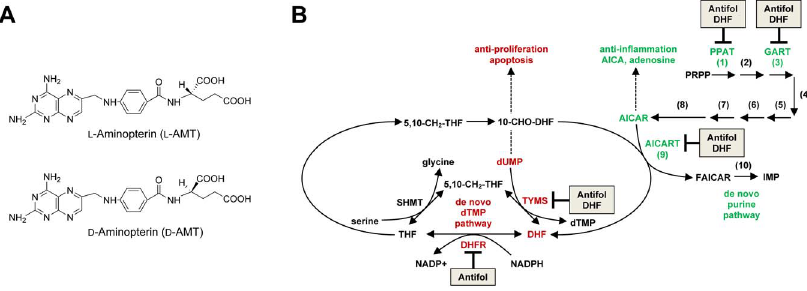
Figure 1. LD-Aminopterin composition and mechanistic model in anti-inflammation. (A) Chemical structure of L-aminopterin ( top ) and D- aminopterin ( bottom ). (B) The anti-inflammatory activity of L-aminopterin and methotrexate have been attributed to inhibition of thymidylate ( red ) and purine ( green ) de novo biosynthesis. In the de novo pathway of thymidylate (dTMP) synthesis, serine hydroxymethyltransferase (SHMT) catalyzes the conversion of serine and tetrahydrofolate polyglutamates (THF) to 5,10-CH 2 -THF and glycine. Thymidylate synthase (TYMS) converts 5,10-CH 2 -THF and deoxyuridine monophosphate (dUMP) to dihydrofolate polyglutamates (DHF) and dTMP. Dihydrofolate reductase (DHFR) completes the cycle by catalyzing the conversion of DHF to THF in an NADPH-dependent reaction. The purine, inosine monophosphate (IMP), is synthesized de novo in 10 chemical steps (shown numbered) catalyzed by six enzymes. The six enzymes are phosphoribosylpyrophosphate amidotransferase (PPAT; 1); a trifunctional enzyme composed of glycinamide ribonucleotide synthetase (GARS; 2), GAR formyltransferase (GART; 3) and aminoimidazole ribonucleotide synthetase (AIRS; 5); formylglycinamidine ribonucleotide synthase (FGAMS; 4); a bifunctional enzyme composed of carboxyaminoi- midazole ribonucleotide synthase (CAIRS; 6) and succinoaminoimidazolecarboxamide ribonucleotide synthetase (SAICARS; 7); adenylosuccinate lyase (ASL; 8); and a bifunctional enzyme composed of aminoimidazolecarboxamide ribonucleotide transformylase (AICART; 9) and inosine monophosphate cyclohydrolase (IMPCH; 10). Evidence indicates that 10-formyl-7,8-dihydrofolate (10-CHO-DHF) is the predominant in vivo substrate for AICART, making AICART and TYMS the only enzymes to produce the DHFR substrate DHF [69]. Inside the cell, L-aminopterin and methotrexate and their polyglutamate metabolites (antifol) bind with high affinity to DHFR, resulting in accumulation of DHF and depletion of the reduced folate pool. Depletion of folates, as well as the direct inhibition by antifol and DHF, have all been implicated in the inhibition of PPAT, GART, AICART and TYMS [22,33,54,70]. In the case of AICART, the accumulation of DHF may cause this reaction to run backwards, since AICAR is normally driven towards the biosynthesis of FAICAR and IMP by the DHFR-catalyzed reduction of DHF to THF, as the equilibrium of this step actually lies in the direction of AICAR formation [60].